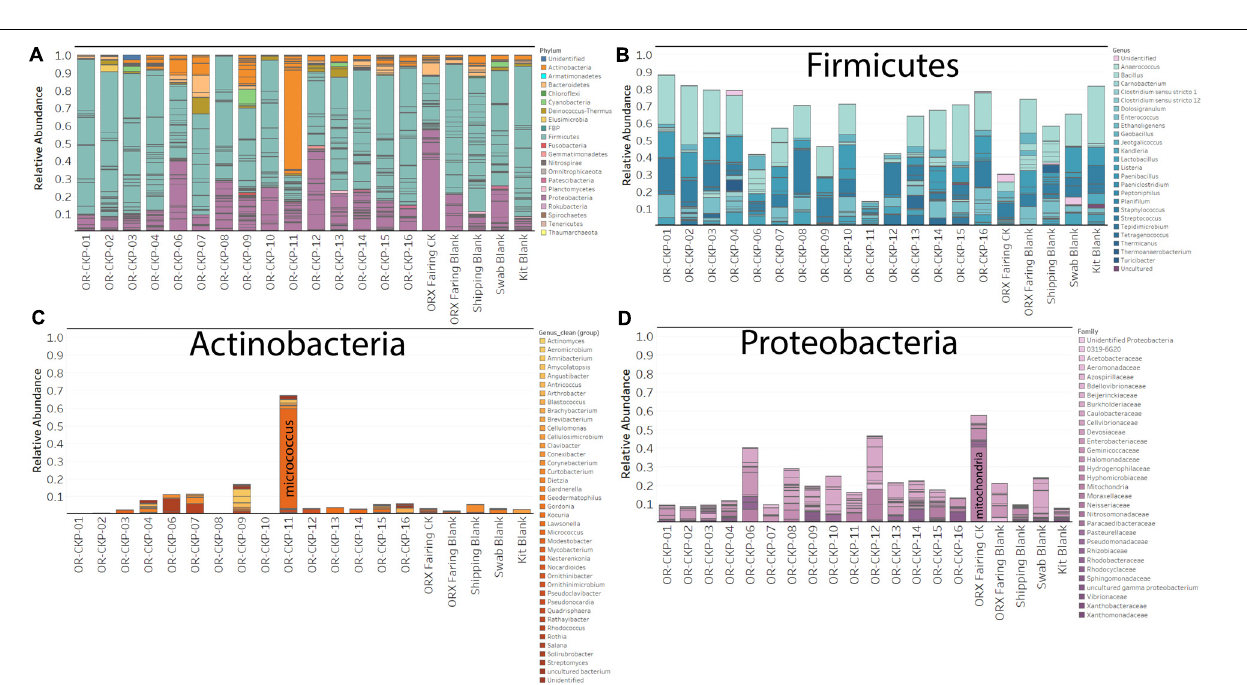
FIGURE 5 | Bar charts detailing bacterial and archaeal sOTUs identified in each sample. Bars are colored by phyla in (A) . Abundant phyla are presented with genus level identifications (B,C) or family level identifications (D) . The most abundant phylum in most samples is Firmicutes (Blue bars; A,B ).